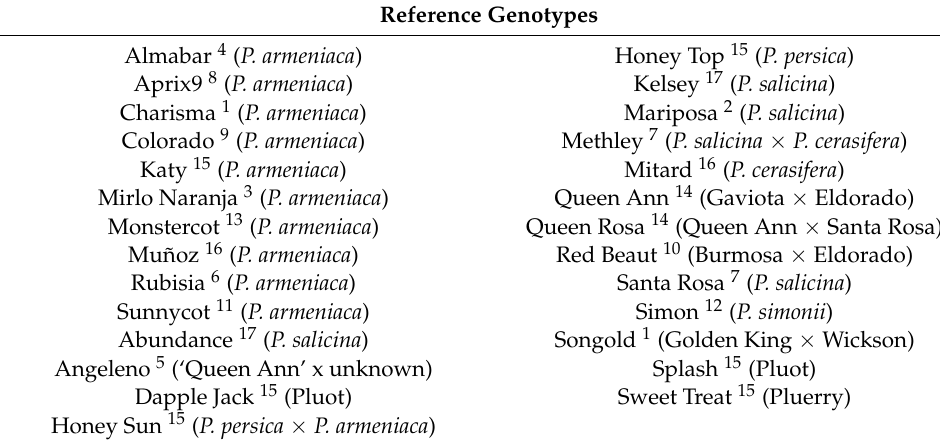
Table 4. Reference genotypes analyzed in this study.